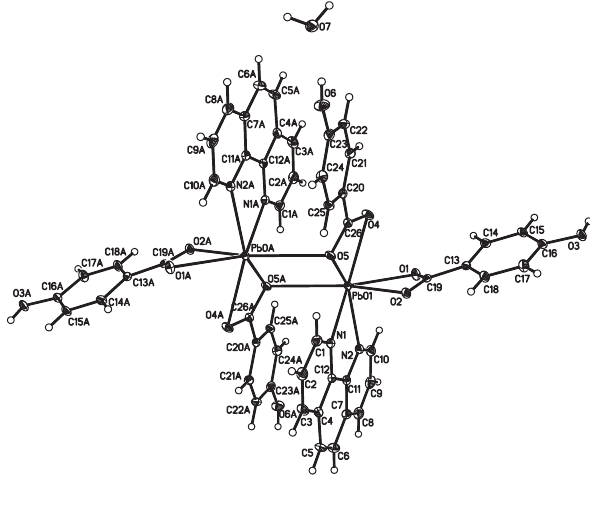
Table 1: Data collection and handling.